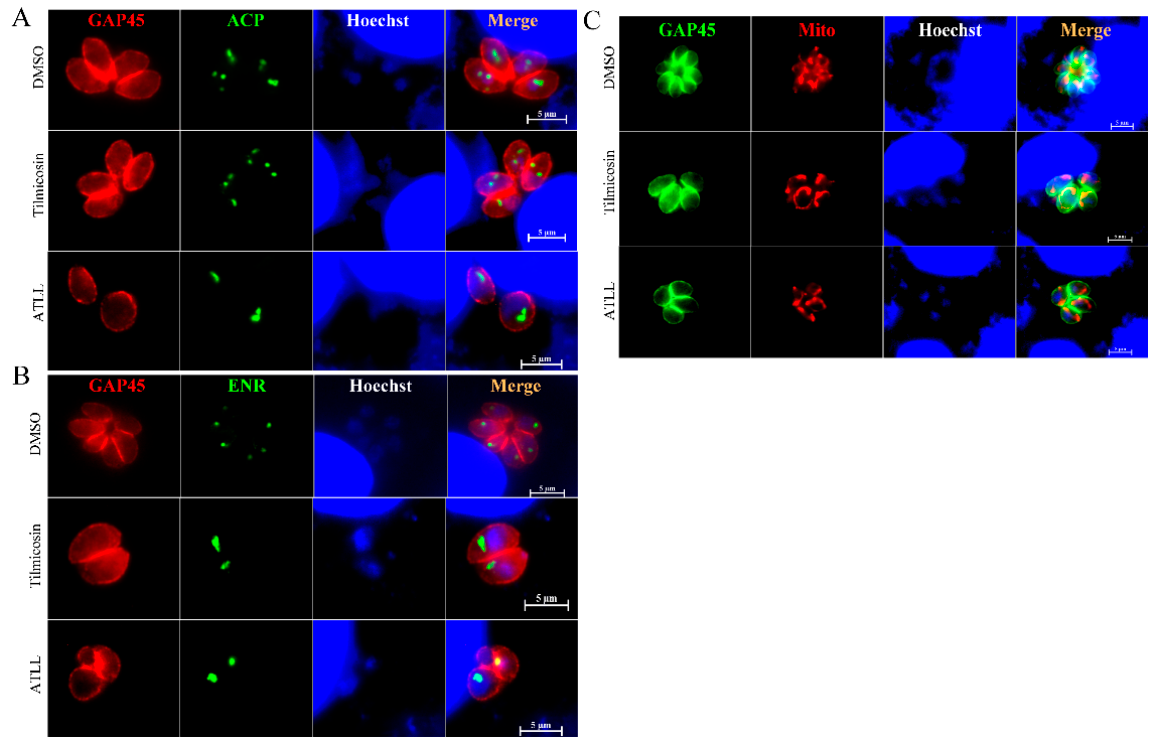
Figure 7. Tilmicosin and ATLL do not affect mitochondria and apicoplast of tachyzoites. ( A , B ) 1 × 10 5 tachyzoites were used to invade HFFs seeded on cover slips and then treated with DMSO, tilmicosin, and ATLL. The apicoplast of the parasites was observed by IFA using specific antibodies against apicoplast proteins (ACP and ENR). Rabbit anti-GAP45 antibody was used as a parasite surface marker (red). In addition, mouse anti-ACP and ENR antibodies were used as an apicoplast marker (green). ( C ) Mitochondria of the parasites were observed using Mito-tracker staining (red). The shapes of the parasites were visualized with anti-GAP45 (green) and nuclear DNA was stained with Hoechst (blue). Scale bar = 5 μ m.